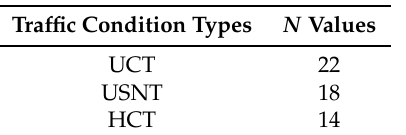
Table 3. Selected N in different traffic conditions.